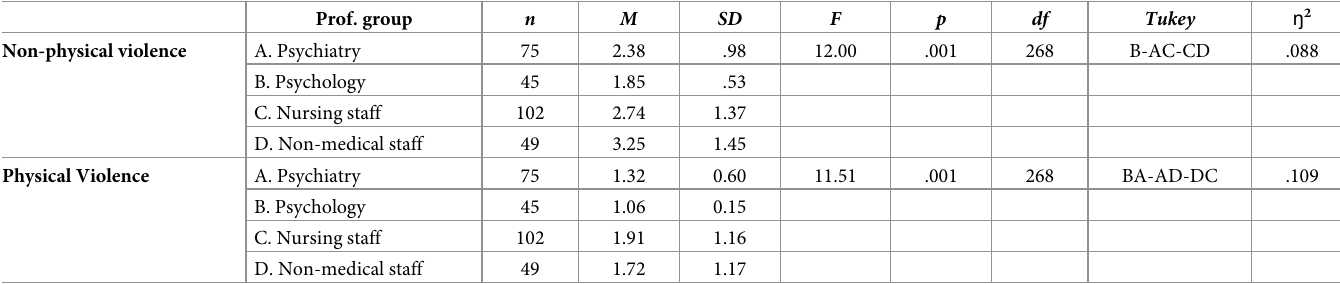
Table 5. Descriptive statistics and ANOVA of Non-physical and physical violence as a function of the professional group. Prof.